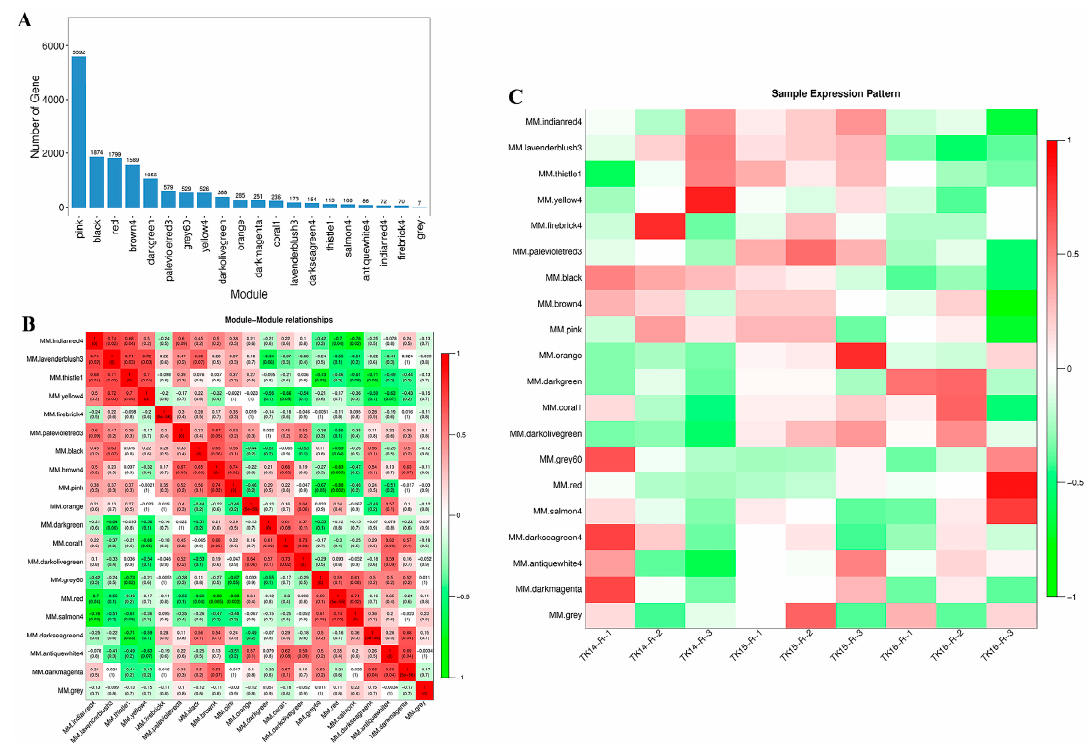
8 Figure 10. Weighted gene co-expression network analysis (WGCNA) of P. sinensis . ( A ) Twenty gene modules of P. sinensis . The X -axis represents the gene module name, and the Y -axis represents the number of each module. ( B ) Relationships among the modules. Red represents a positive relationship, and green represents a negative relationship. ( C ) Analysis of the relationship of the gene modules and the CR samples. Each row represents a gene module, and each column represents a sample. Red represents a positive relationship, and green represents a negative